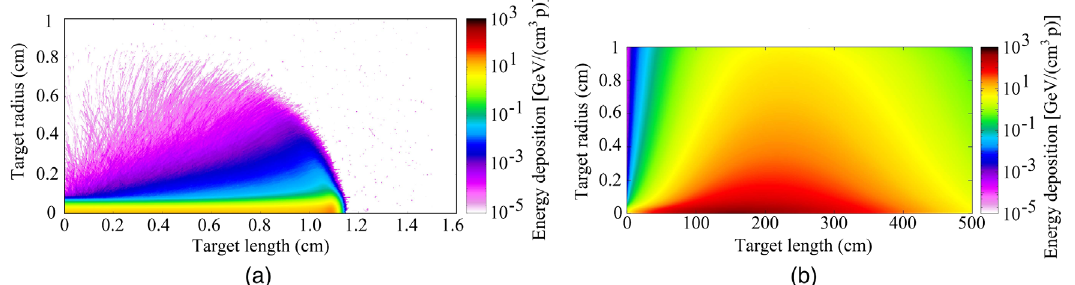
peaks).FIG. 11. Two-dimensional energy deposition in units of GeV = cm 3 per proton in a solid graphite target at the energies of (a) 50 MeV and (b) 50 TeV. The rms beam size is σ ¼ 0 . 2 mm. 1.0 mm, with the peak values of 25 . 0 , 10 . 6 , and Figs. 12(a) and 13(a), respectively. The radial energy 2 . 3 GeV = ð cm 3 p Þ , respectively, which are approximately deposition at the longitudinal positions where we have the maximum on-axis energy deposition is shown in one-third of the corresponding values in the case of copper Figs. 12(b) and 13(b). At 50 MeV, the Bragg peaks lie (Fig. 3). For 50 TeV, the peaks are much wider than that in at L ¼ 1 . 09 cm for the three beam sizes of 0.2, 0.4, and Fig. 4. The maximum energy deposition for the beam size